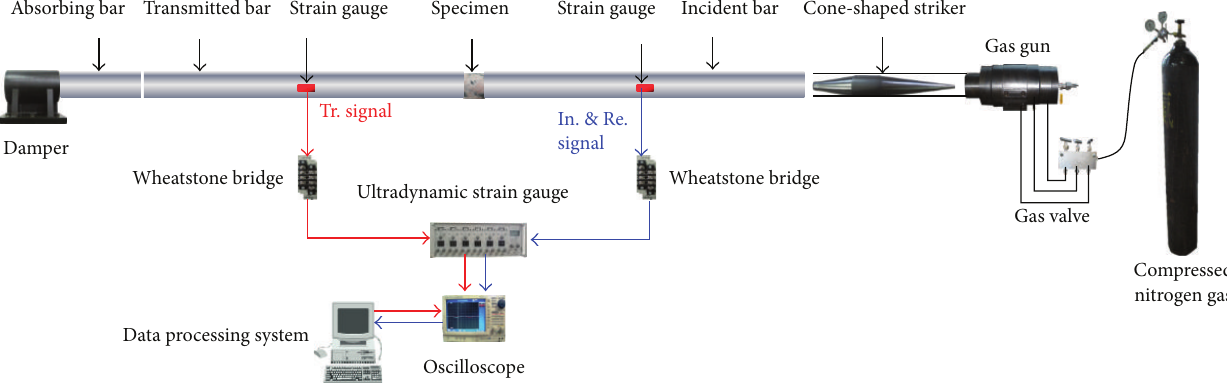
Figure 2: The schematic of the SHPB system.